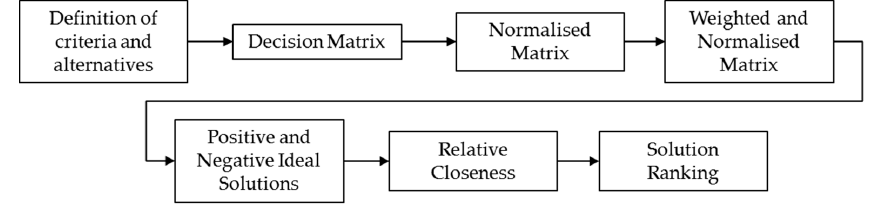
Figure 1. TOPSIS methodology.